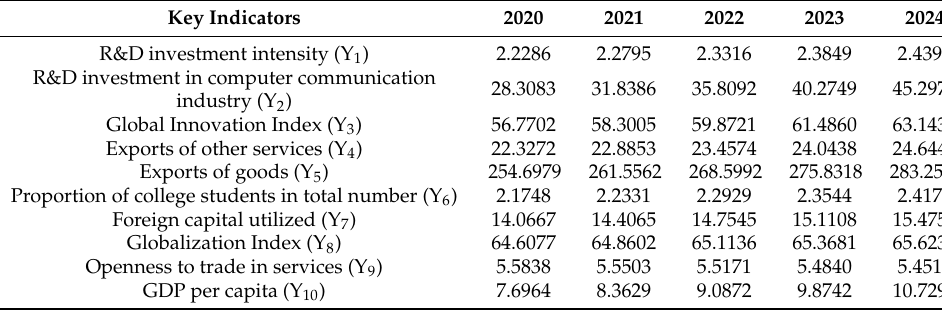
Table 6. Predictive values of key indicators by GM (1,1)